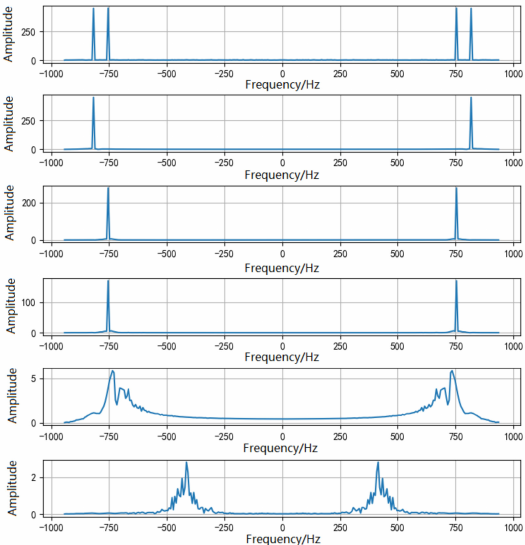
Figure 9. IMF Component Corresponding Spectrum of Fault